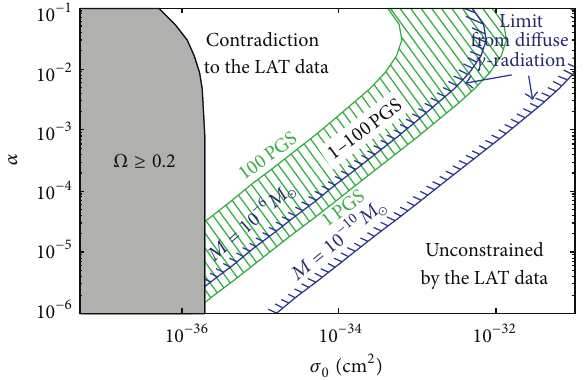
Figure 1: Allowed and forbidden regions of parameters 𝛼 and 𝜎 0 are shown as they are obtained on the base of Fermi LAT data on PGS and diffuse 𝛾